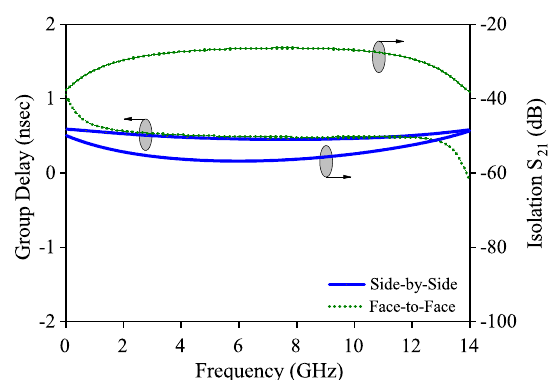
FIGURE 13: Proposed single element group delay and isola-